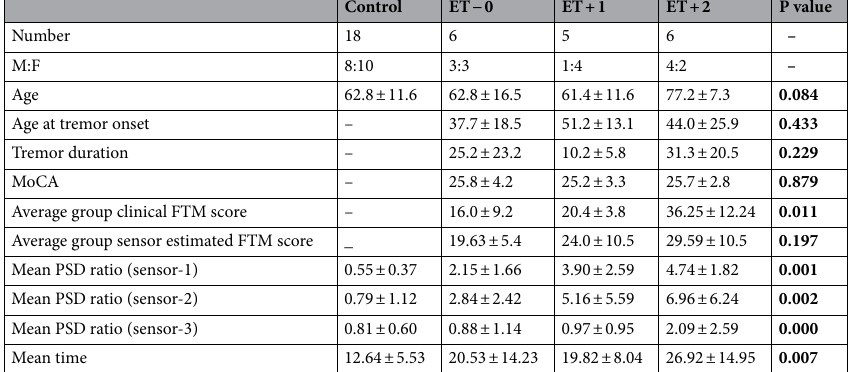
Table 1. The demographic, clinical and estimated sensors information and the P-value of the Kruskal–Wallis test between the groups of controls, ET − 0, ET + 1, ET + 2. Significance values are in